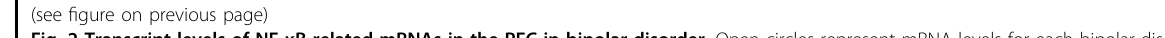
Fig. 2 Transcript levels of NF- κ B-related mRNAs in the PFC in bipolar disorder. Open circles represent mRNA levels for each bipolar disorder subject relative to the matched unaffected comparison subject. Data points to the left of the unity line indicate higher mRNA levels in the bipolar disorder subject relative to the comparison subject. Percent difference in diagnostic group means and primary statistical analysis results with Bonferroni-Holm adjusted p values are provided for each transcript. Mean ± standard deviation mRNA levels for unaffected comparison subjects and bipolar disorder subjects, respectively, are: IL-1R (0.0017± 0.00057 and 0.00259 ± 0.0018); TNFR (0.00962± 0.0018 and 0.0127 ± 0.0058); NF- κ